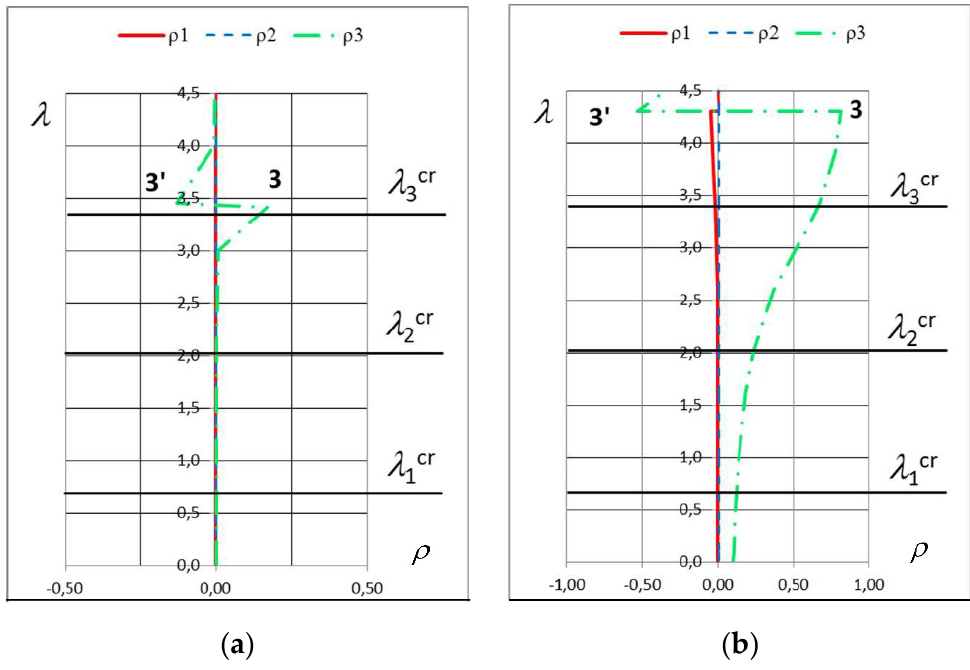
Figure 14. Coefficient ρ for geometrical imperfections developed according to the third buckling mode: ( a ) small ( m 3), ( b ) large ( d 3).